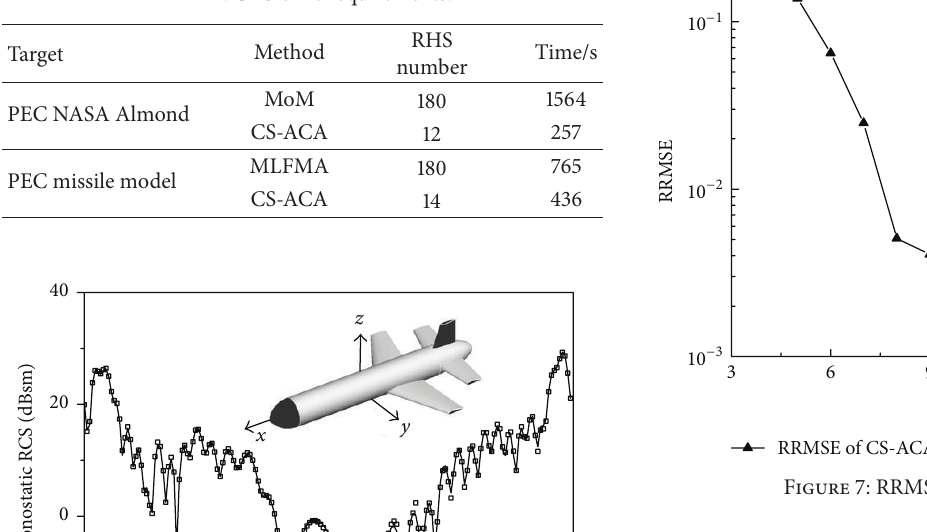
Table 1: CPU time requirements.